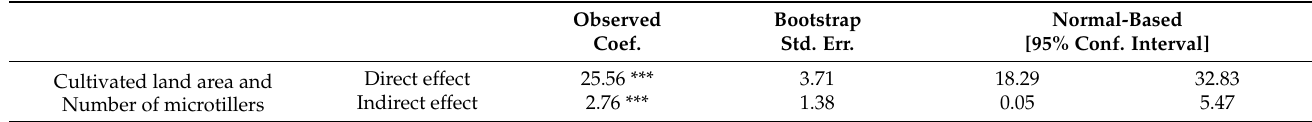
Table 5. Results for mediating effect test with Bootstrap